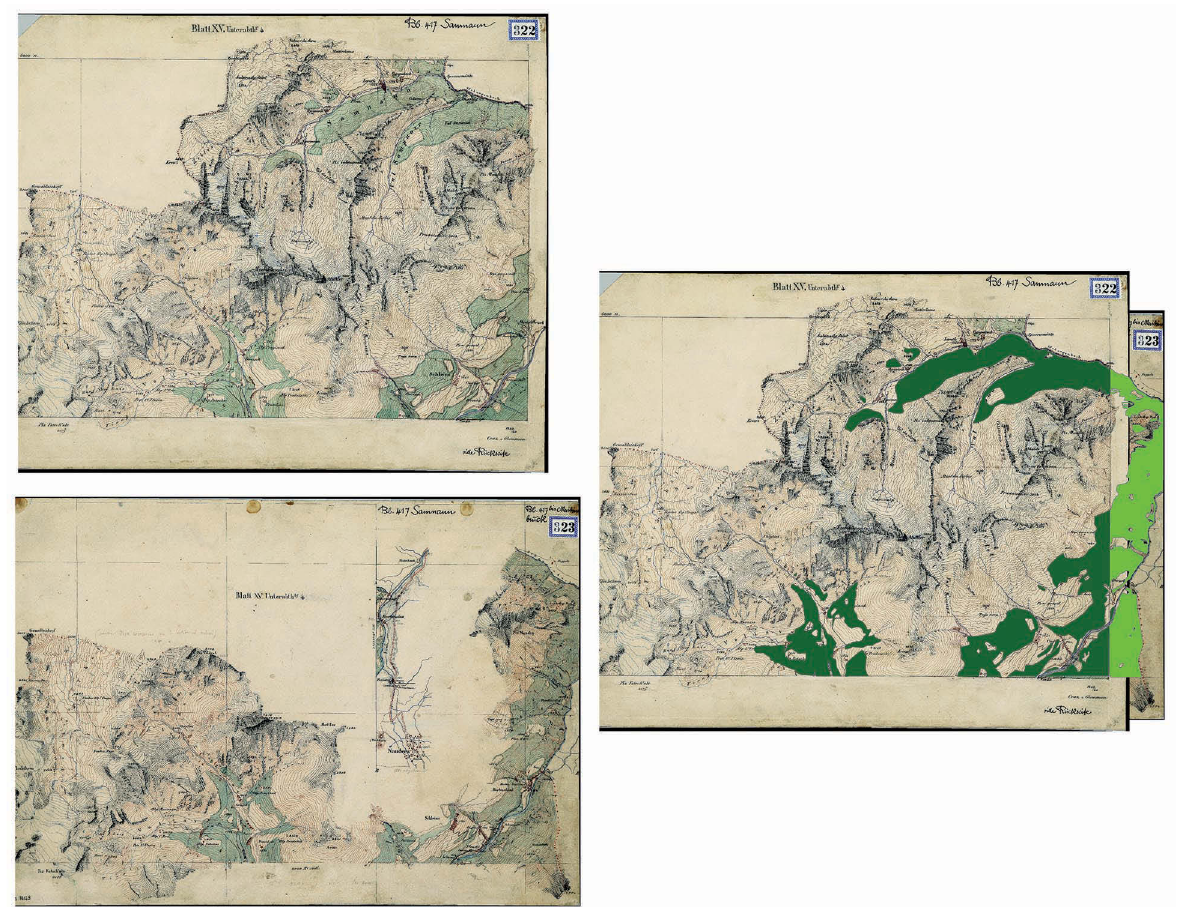
Fig. 3. Overlapping map sheets dating from 1850 (upper left) and 1849 (lower left). Due to quality issues (mapping of a larg- er continuous area) the overlapping area was mapped from the 1850 map (dark green) while the smaller area on the right side was only depicted on the 1849 map (light